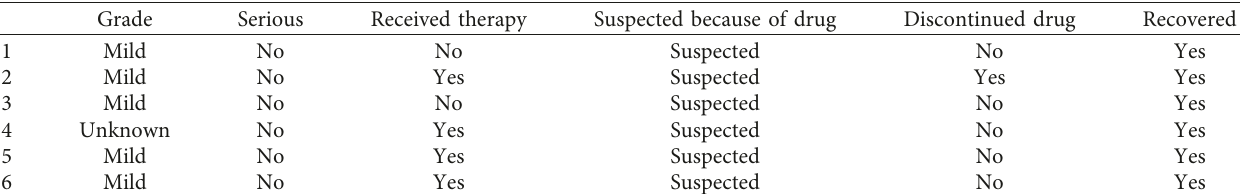
Table 5: Adverse